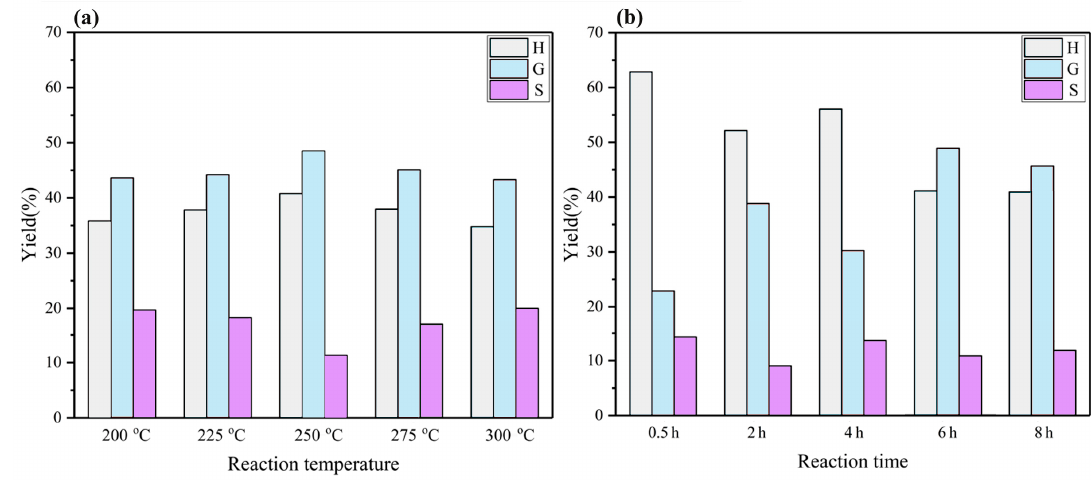
Figure 6. The SGH-type distribution of phenolic monomers. ( a ) The SGH-type distribution at different reaction temperatures; ( b ) the SGH-type distribution at different reaction times.